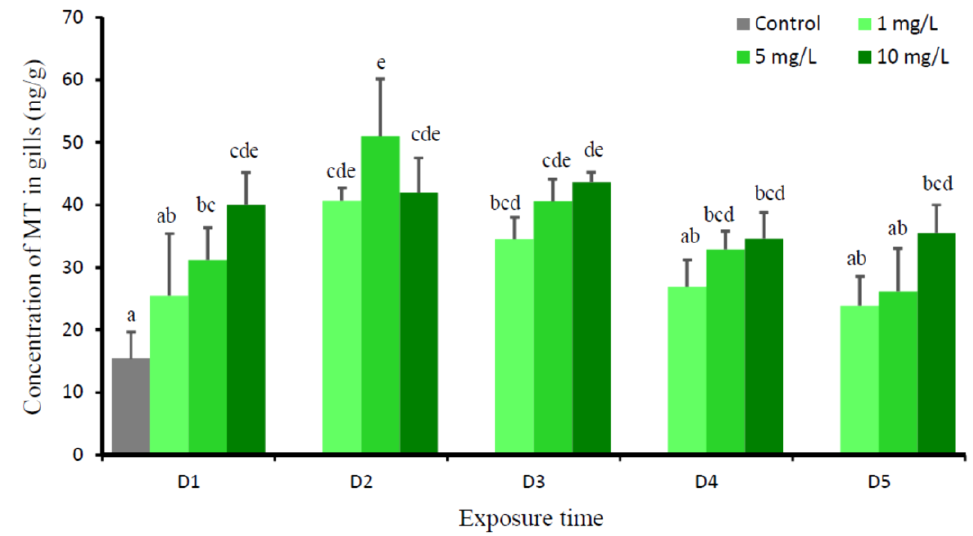
Figure 2. Mean concentration of metallothionein (MT) (ng/g) in gills of O. niloticus of the control group and after exposed to 1, 5, and 10 mg Cu/L. Different lowercase letter indicates significance difference according to Tukey multiple comparison test ( P < 0.05).